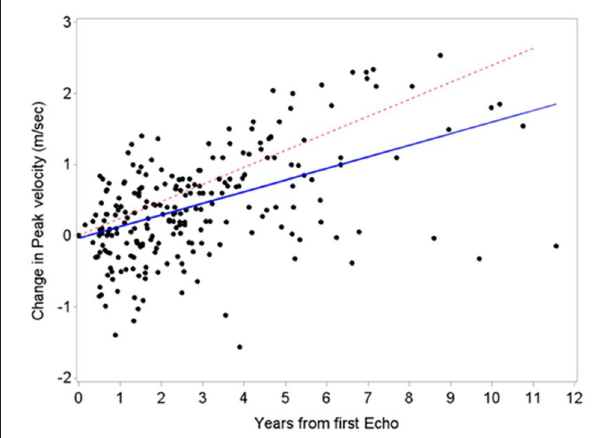
FIGURE 3 | Comparison of aortic stenosis progression between patients with cancer and a historical cohort. Similar aortic stenosis progression based on peak velocity between patients with cancer (blue line, estimated slope 0.16 m/s/year) and a historical cohort by Rosenhek et al. (18) (red line, estimated slope 0.24